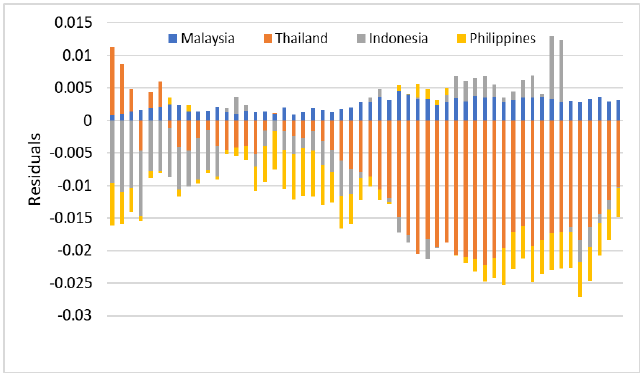
Figure 6. Residuals obtained from the NARX model prediction of CO 2 emissions.